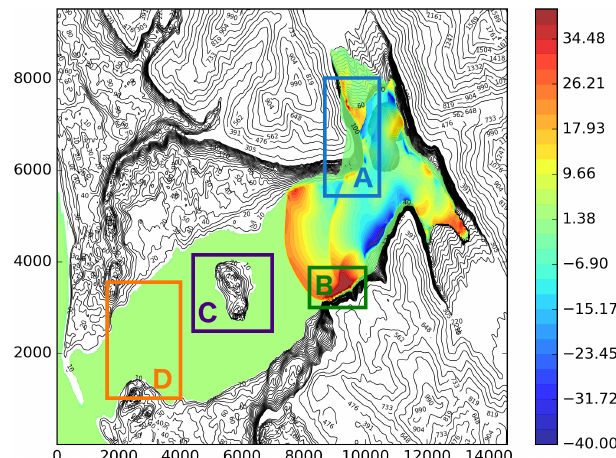
Figure 6. Location and spatial extension of the four regions consid- ered to compute maximum run-up for the sensitivity